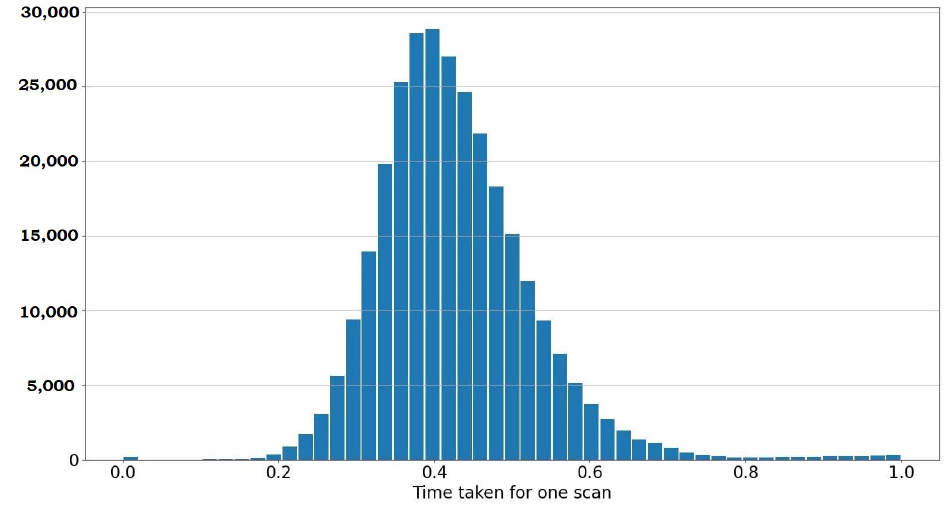
Figure 13. Latency performance for current implementation ( x -axis time in units of